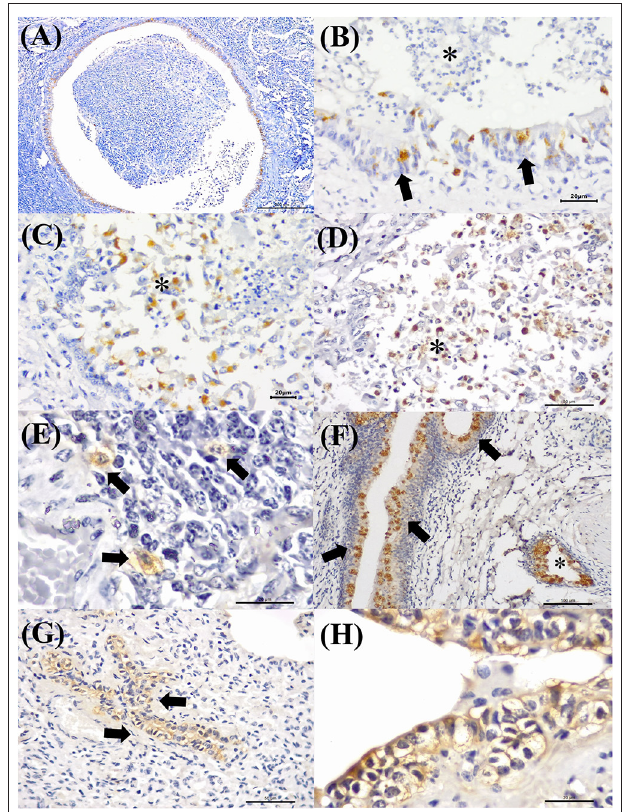
FIGURE 8 | Immunohistochemical identification of BVDV and MCFV antigens in cattle with bronchopneumonia with BRD. (A) There is positive intracytoplasmic immunoreactivity to BVDV in the bronchial cells of an ectatic bronchiole due to bronchiectasis, (B) closer view of epithelial cells (arrows) and negative immunoreactivity in neutrophils (asterisk). (C,D) Immunoreactivity to MCFV antigens within necrotic bronchiolar epithelial cells (asterisk), (E) alveolar macrophages (arrows), (F) goblet cells (arrows), normal cells (asterisk), and (G) degenerated bronchiolar epithelial cells (arrows); (H) closer view of the degenerated bronchiolar epithelial cells. Immunoperoxidase counterstained with hematoxylin. Bar: (A) 200 µ m; (B,C,E,H) 20 µ m; (D,G) 50 µ m; (F) 100 µ